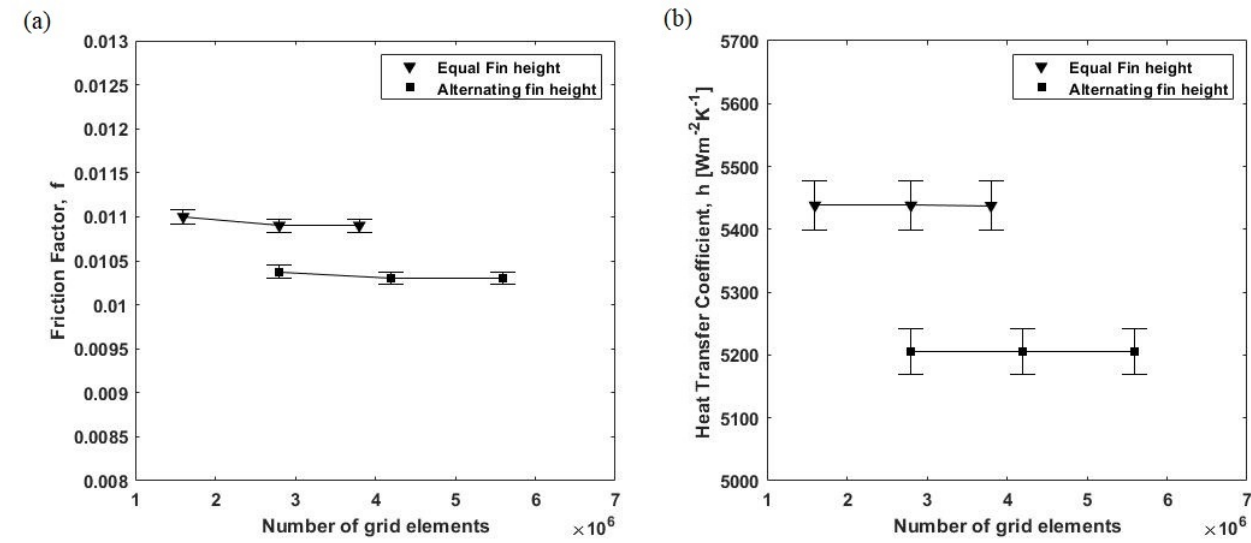
Figure 4. Grid size dependence of ( a ) friction factor; ( b ) heat transfer coefficient, with respect to the number of grid cells.